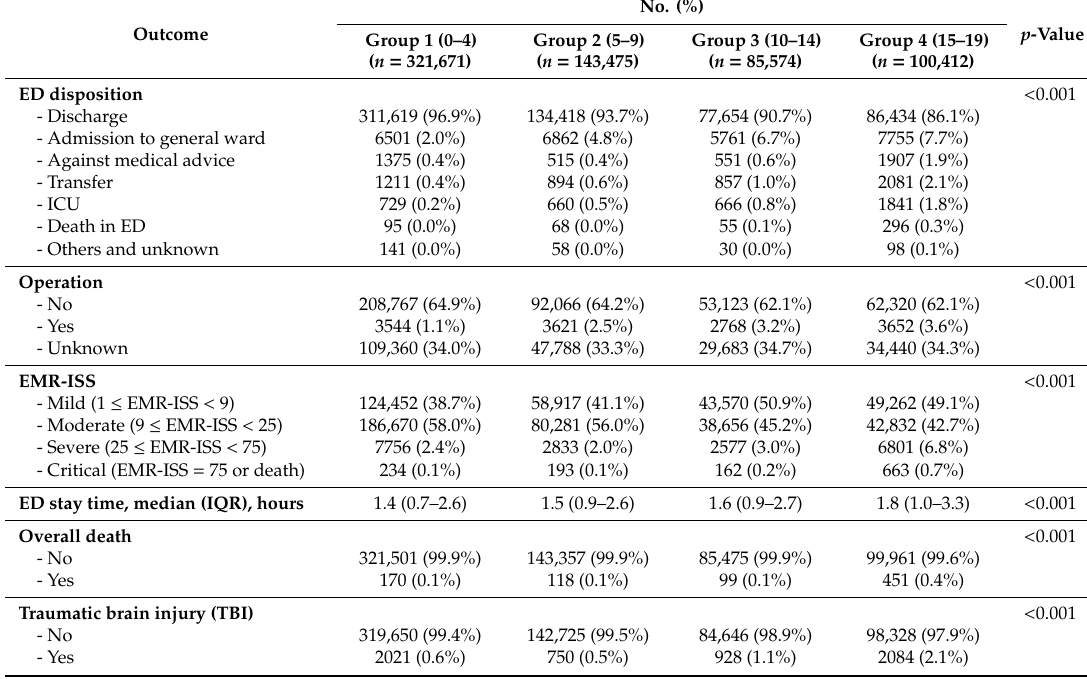
Table 2. Outcomes of pediatric injury patients by age